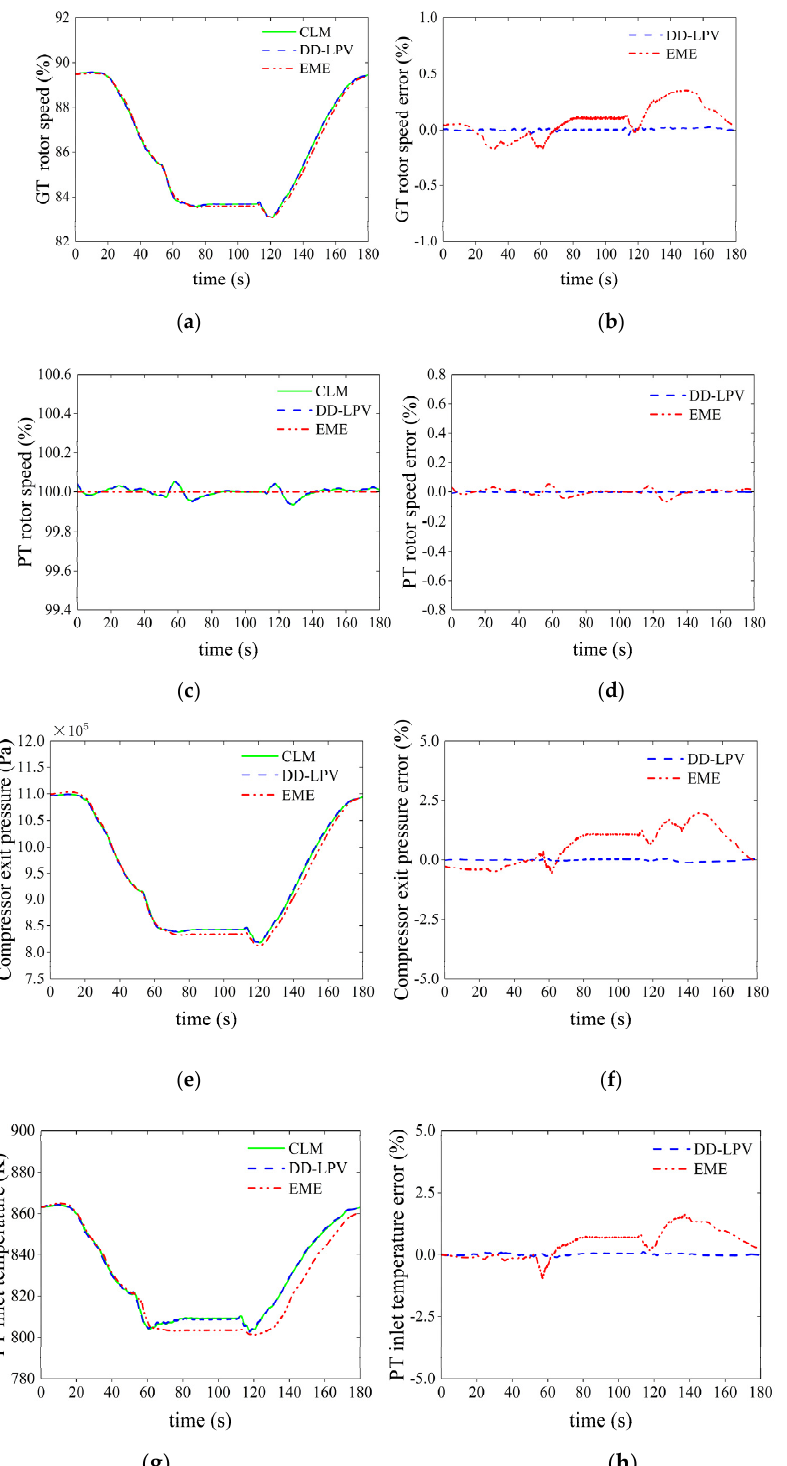
Figure 5. Prediction comparison of DD-LPV model and EME model to CLM at time k + 5 (at 1000 m, without measurement noise). ( a ) Prediction of GT rotor speed. ( b ) Relative error of GT rotor speed prediction. ( c ) Prediction of PT rotor speed. ( d ) Relative error of PT rotor speed prediction. ( e ) Prediction of compressor exit pressure. ( f ) Relative error of compressor exit pressure prediction. ( g ) Prediction of PT inlet temperature. ( h ) Relative error of PT inlet temperature prediction.